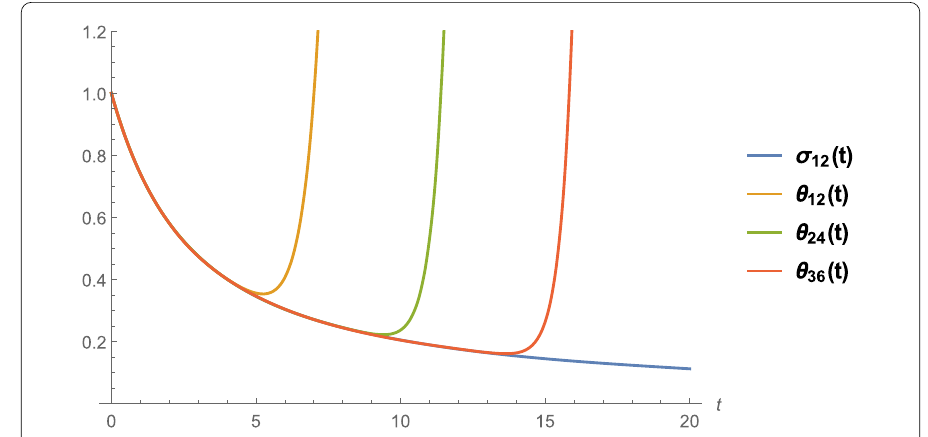
Figure 3 Comparison between σ 12 (present) and θ 12 , θ 24 , and θ 36 in Ref. [42] at λ = 1, ξ = 1.5, and α = 0.5